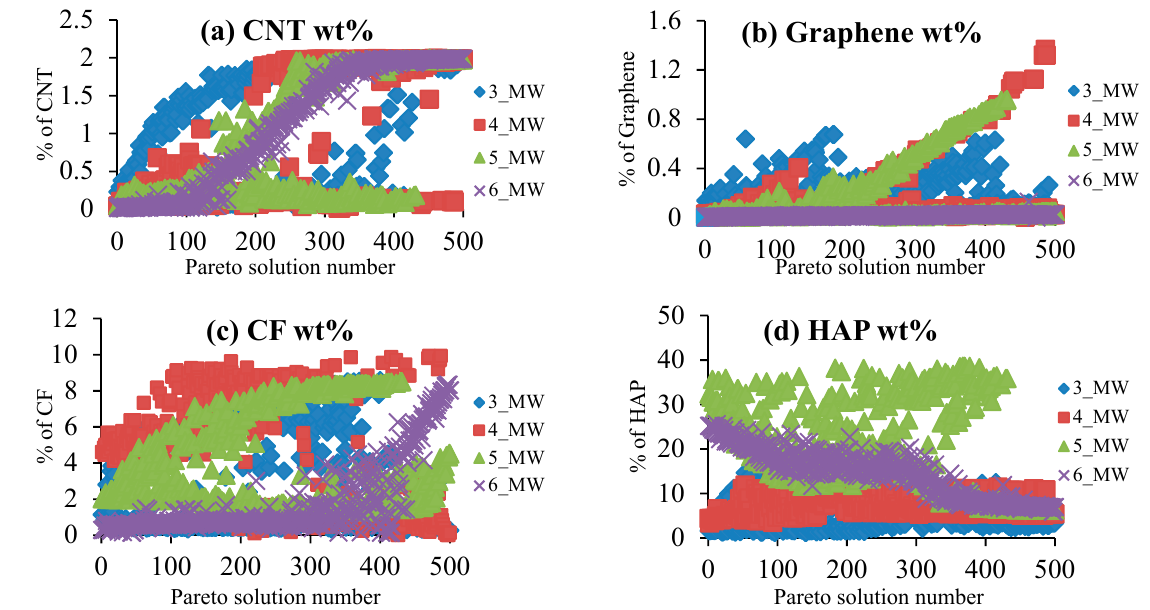
Figure 8. Deviation of the particles in the Pareto solutions for E, CoF, and